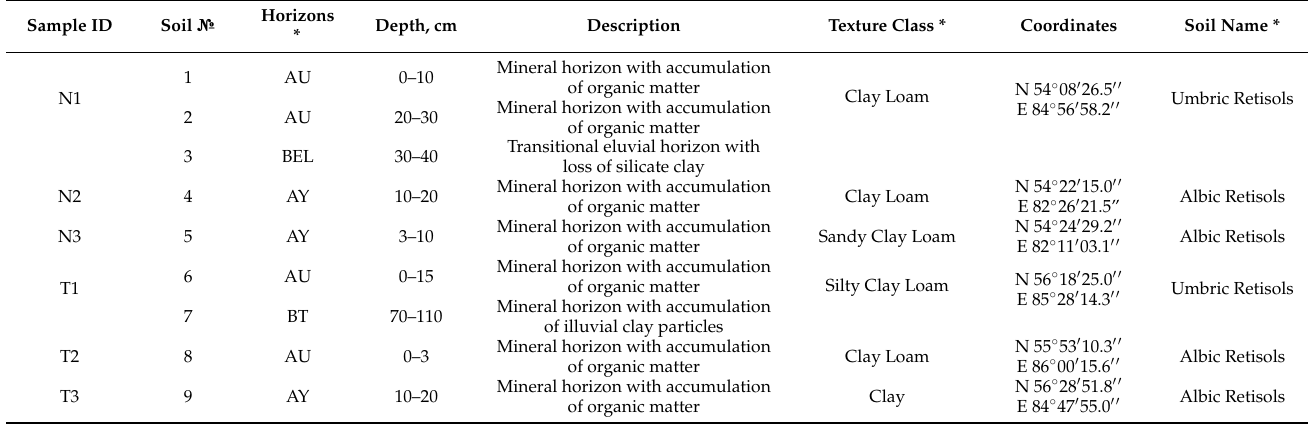
Figure 1. The study area (origin maps form ESRI.ArcGIS.Imagery: Geographic information system company, West Redlands, California, United States of America). The sample ID corresponds to Table 1. Table 1. The description of the soils